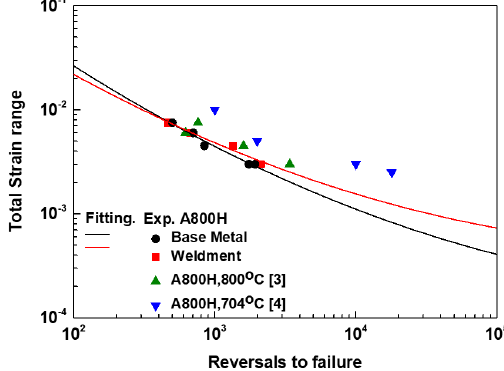
Figure 9. Comparison of CMB curves of Alloy 800H from the test and other existing data in literatures [3,4].